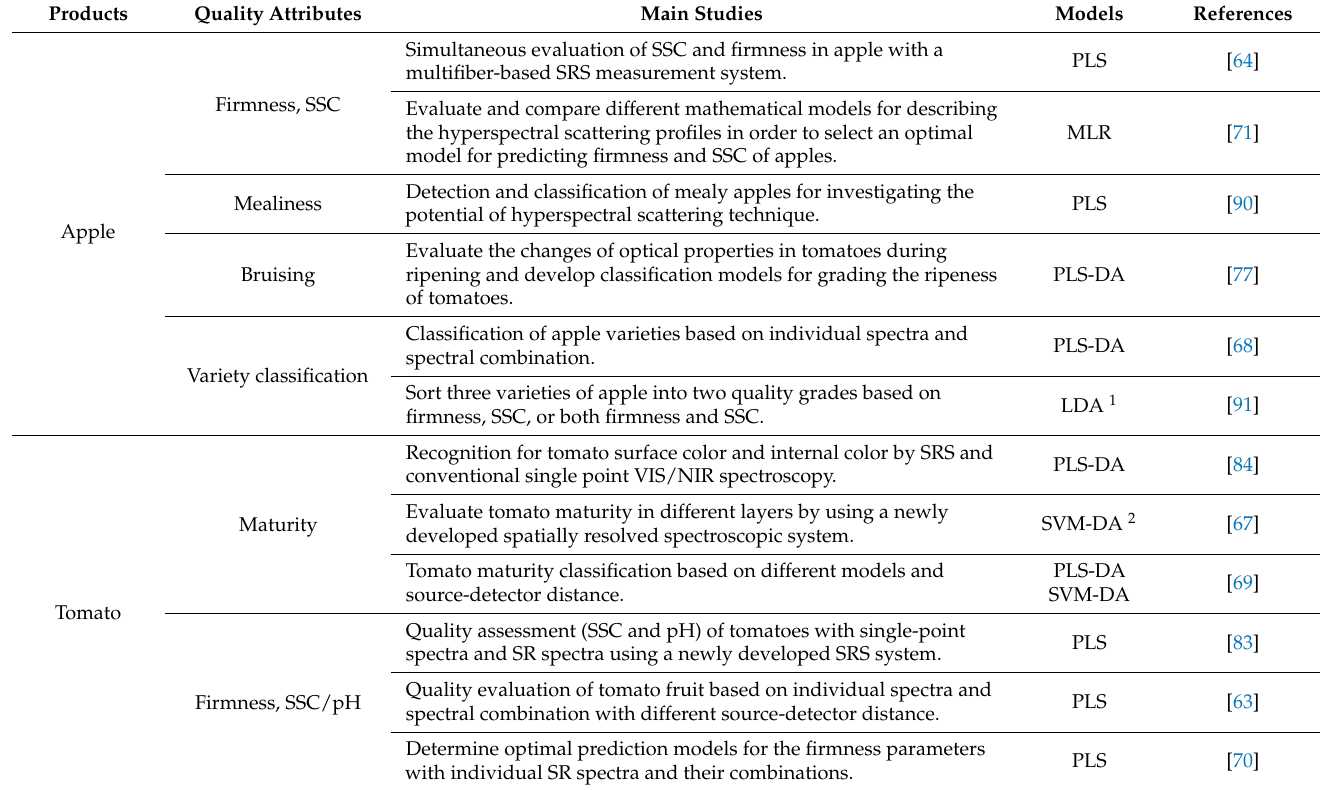
Table 3. Post-harvest quality assessment by spatially resolved spectra of fruits and